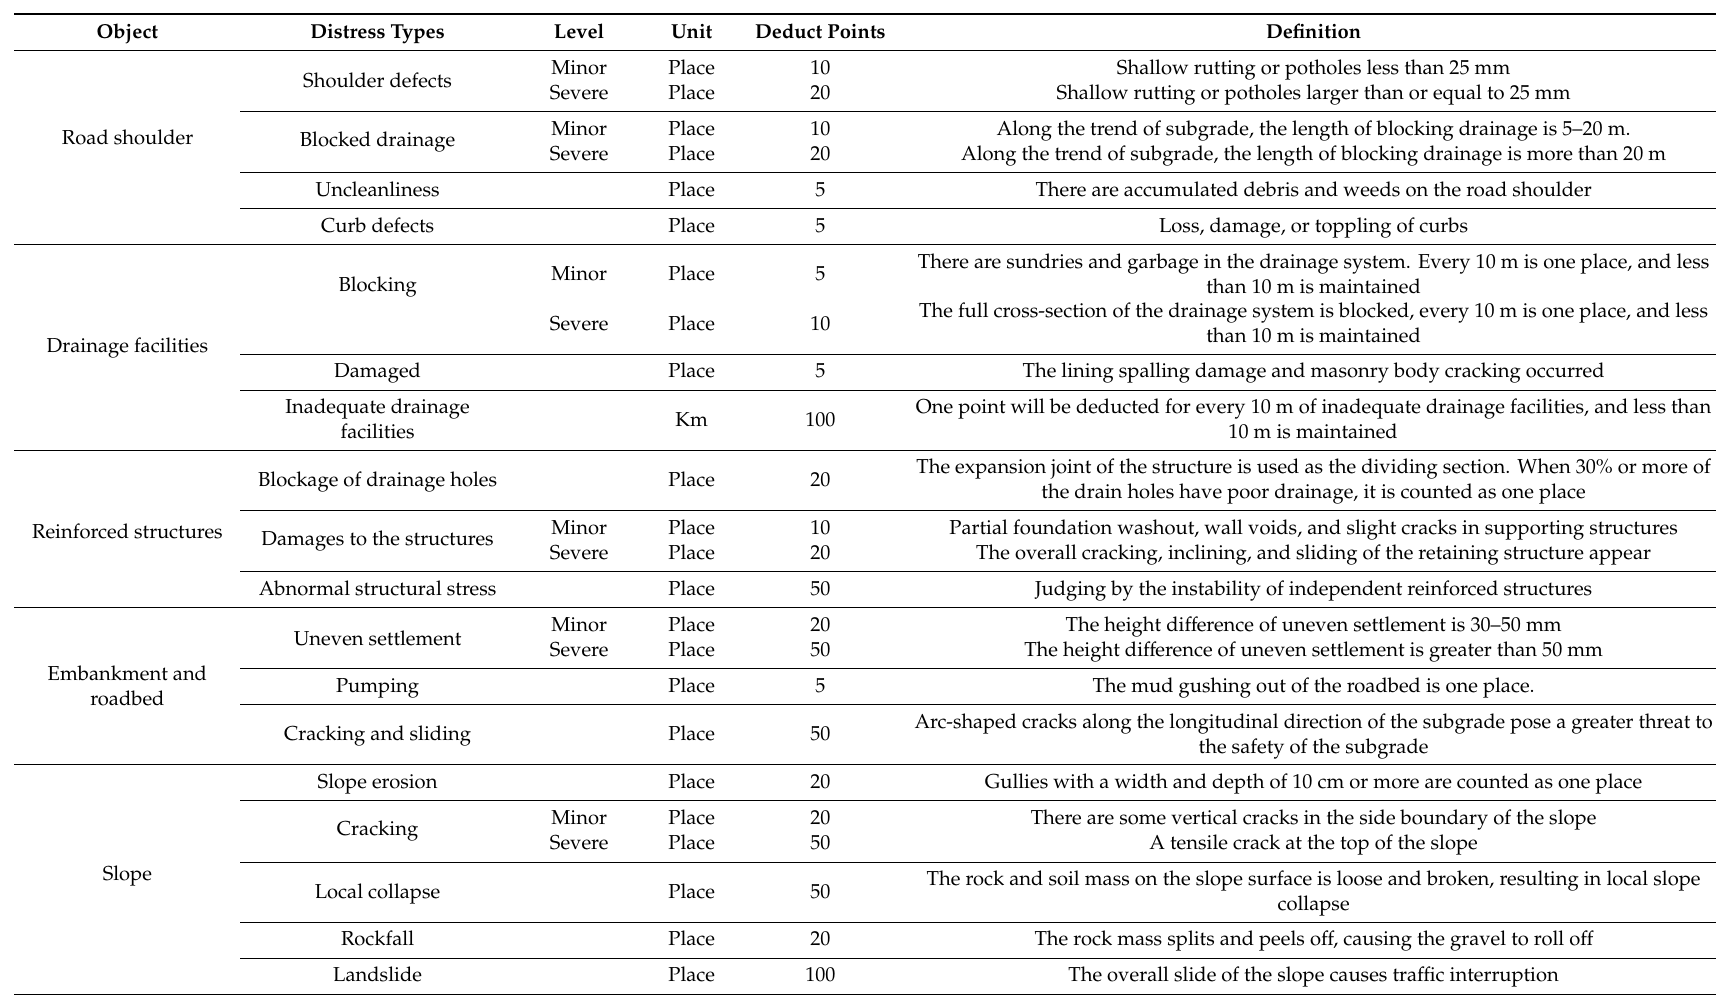
Table 1. Subgrade distresses data collection and determination of the deduction